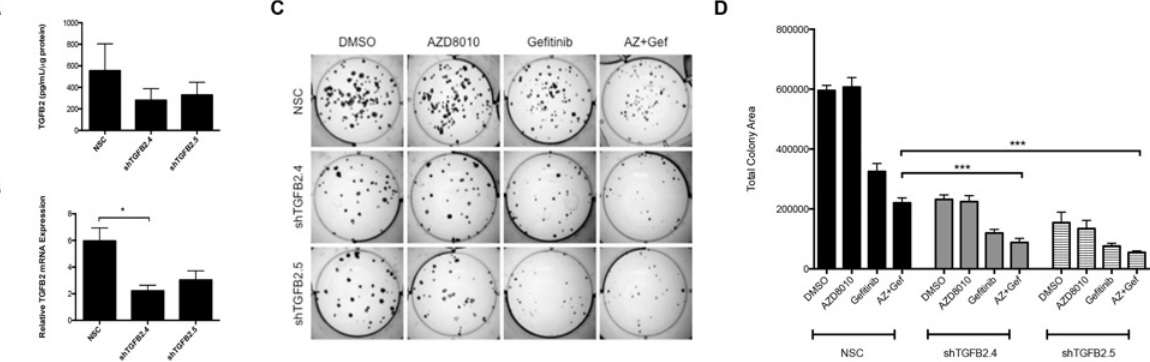
Fig 3. RNAi-mediated silencing of TGF-2 inhibits clonogenic growth in UMSCC25 cells. 2 independent shRNA sequences targeting TGF- β 2 or a non- silencing control were transduced into UMSCC25 cells using a lentiviral construct to create 3 cell lines: shTGFB2.4, shTGFB2.5, and NSC. A. qRT-PCR was performed to demonstrate that TGF- β 2 mRNA was decreased with the shRNA compared to the NSC. B. An ELISA performed on media from the knockdown cells demonstrates decreased TGF- β 2 protein secretion into the media. C. Representative images of the clonogenic assay where cells were treated with